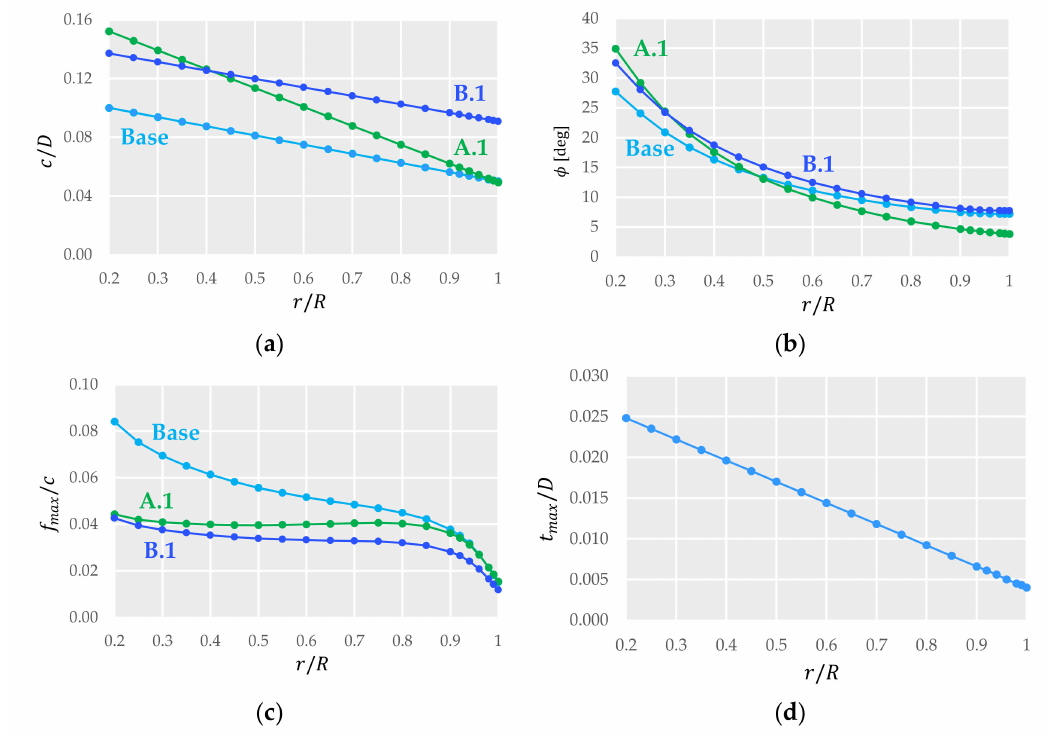
Figure 7. Blade geometry for base and optimized cases: ( a ) c / D ; ( b ) φ ; ( c ) f max / c ; ( d ) t max / D . The pressure on both sides of the blade for the base case, the global maximum